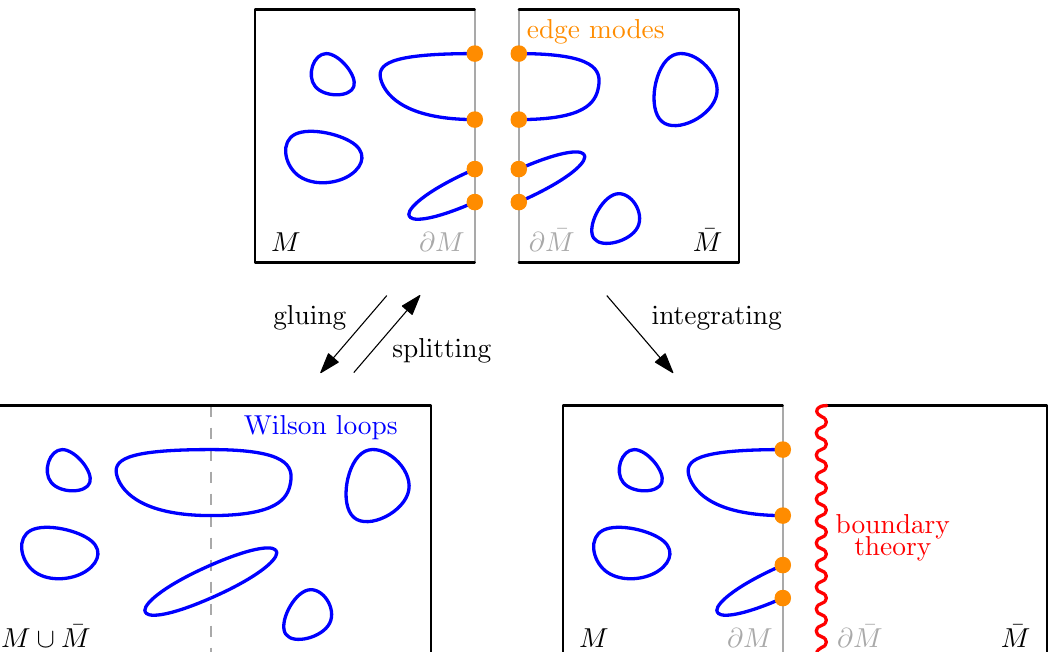
Figure 1 . On the top, we have a same gauge theory defined on two neighboring manifolds with boundaries. Each factor contains bulk fields and edge modes. Integrating out the edge modes leads to the theory defined over M [ (cid:22) M and, conversely, the splitting of M [ (cid:22) M into subregions requires to introduce edge modes on which Wilson lines can end. Once the theory is split into factors associated with the regions M and (cid:22) M , one bulk region can be integrated out, thereby leading to an effective boundary dynamics for the edge modes. This latter will in turn be seen by and contribute to the entanglement